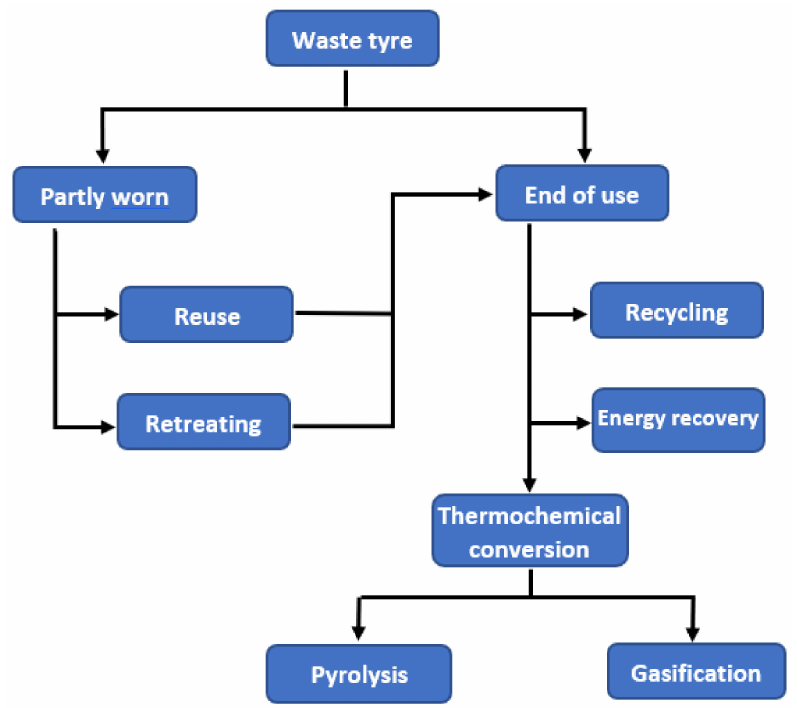
Figure 1. A typical waste tire management